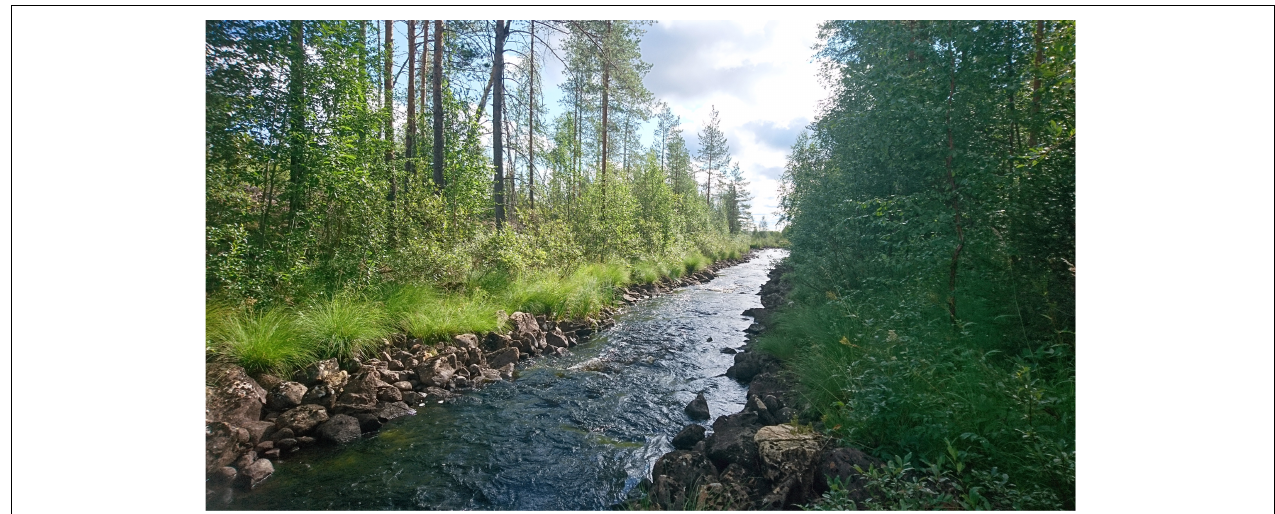
FIGURE 4 | Bjurbäcken, a channelised tributary to Vindel River, Sweden. Photo by Jacqueline